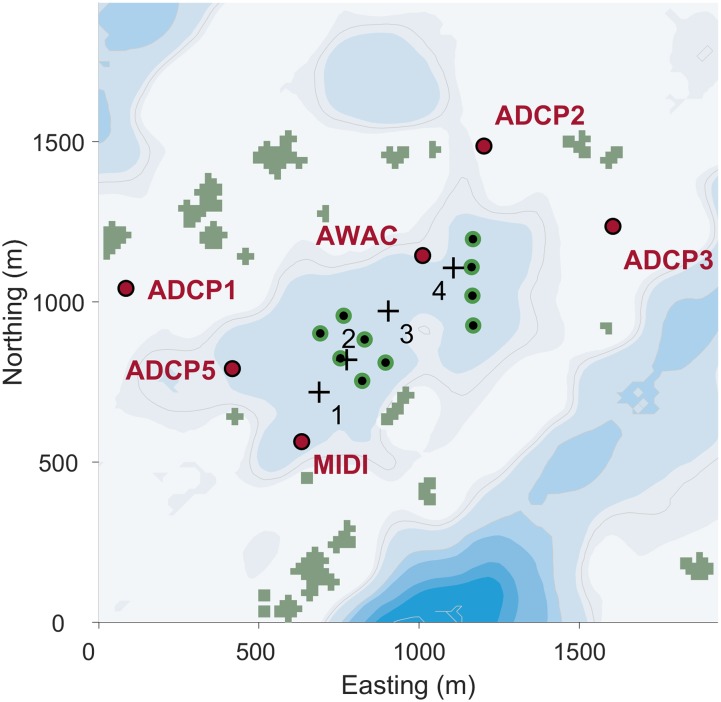
Layout of the farm at Rataren.The farm is located at 63.8°N; 8.5°E. The position of the cages (green and black dots) and the profilers (red dots) are indicated. The background colors indicate bottom depth (the darker, the deeper), and the thin gray curves are 25, 50 and 100 m isobaths. Land points are olive colored.